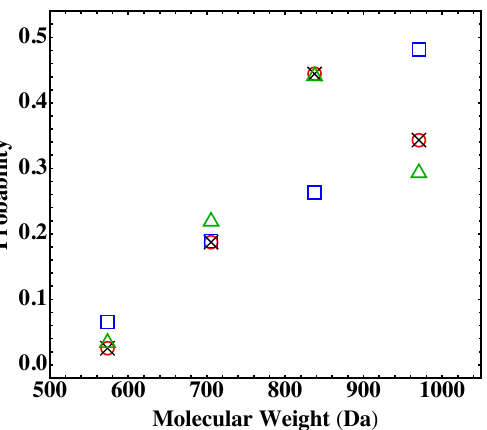
Figure 4. Probabilities of the four possible final products for the system in Table 1. The results are from the Flory-Stockmayer theory (red circles), the MC simulations using Equation (18) (black crosses), the MC simulations using Equation (19) (blue squares), and a simple statistical model discussed in the main text (green triangles). The MC results are the averages of 10,000